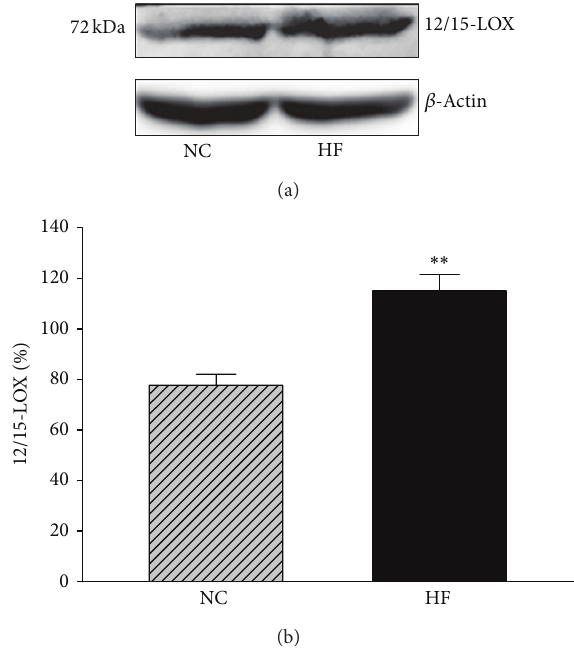
Figure 5: (a) Western blot analyses of sciatic nerve 12/15-LOX. Equal protein loading was confirmed with 𝛽 -actin antibody. (b) Densitometric analysis of 12/15-LOX expression in sciatic nerve. ∗∗ 𝑃 < 0.01 . NC and HF, abbreviations for “normal diet” and “high- fat diet,” represent the control and HFD-fed groups,